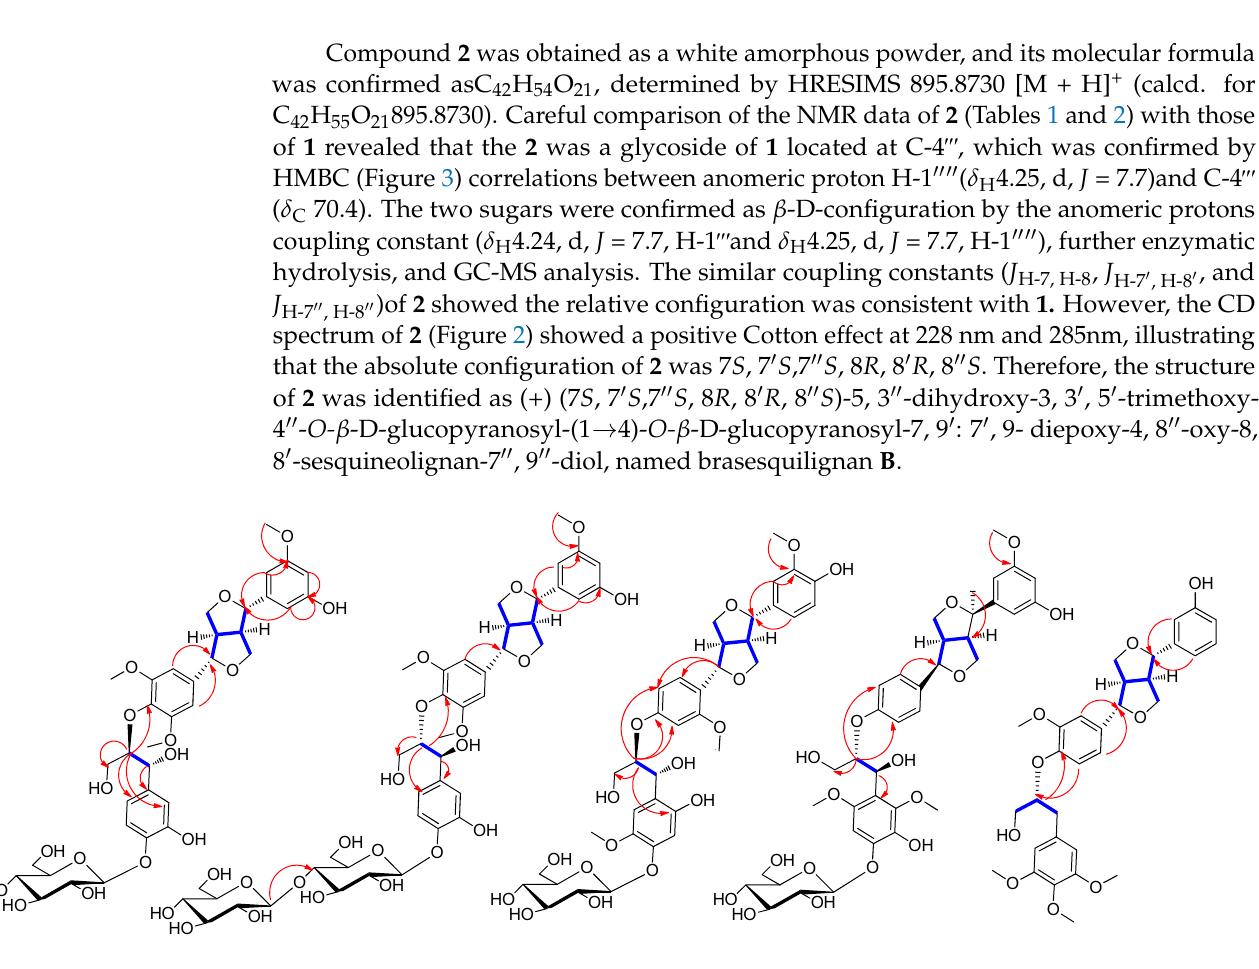
Figure 3. Key 1 H- 1 H COSY and HMBC correlations of compounds 1 – 5. Compound 3 was obtained as a white amorphous powder, and its molecular formula was confirmed asC 36 H 44 O 16 by HRESIMS 755.2473 [M + Na] + (calcd. forC 36 H 44 NaO 16 , 755.2527). The 1 H NMR and 13 C NMR data (Tables 1 and 2) of 3 were quite similar to